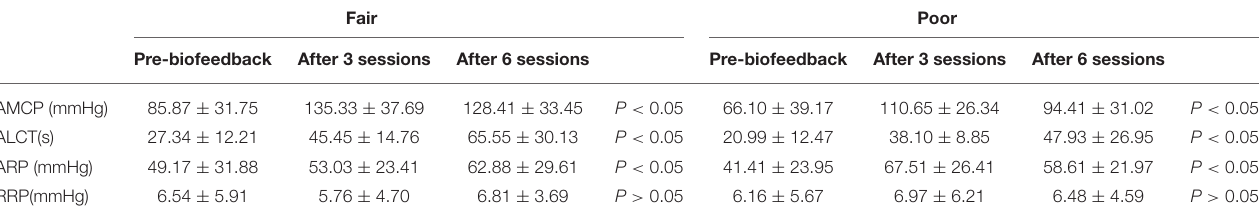
TABLE 3 | Effect of biofeedback on anorectal manometry parameters of patients.